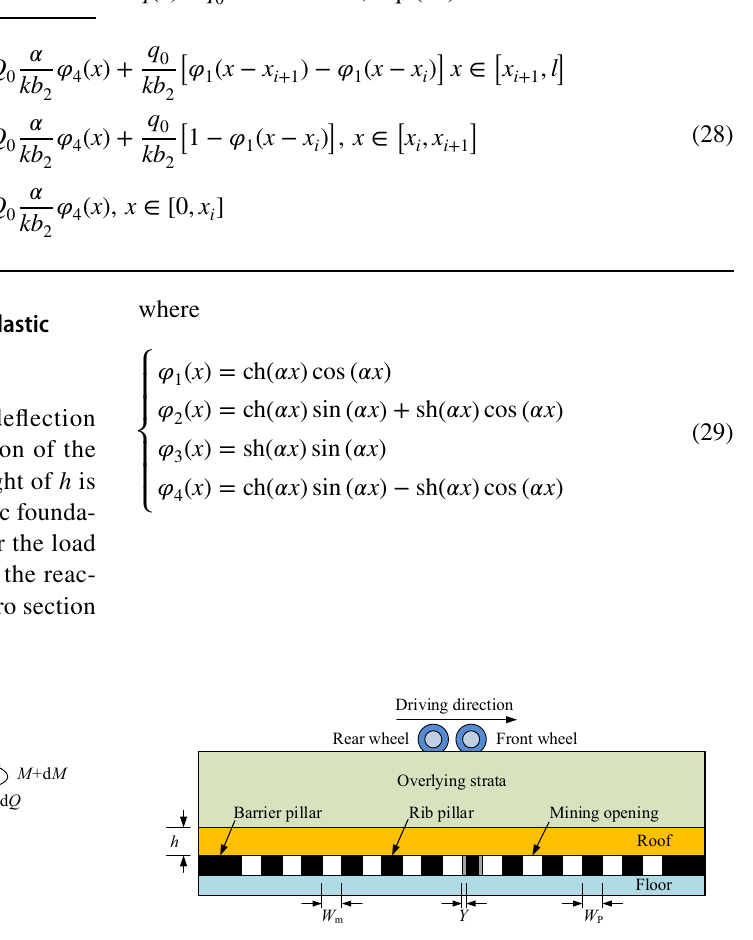
Fig. 6 Dynamic load of front and rear wheels of a mining haul truck under full